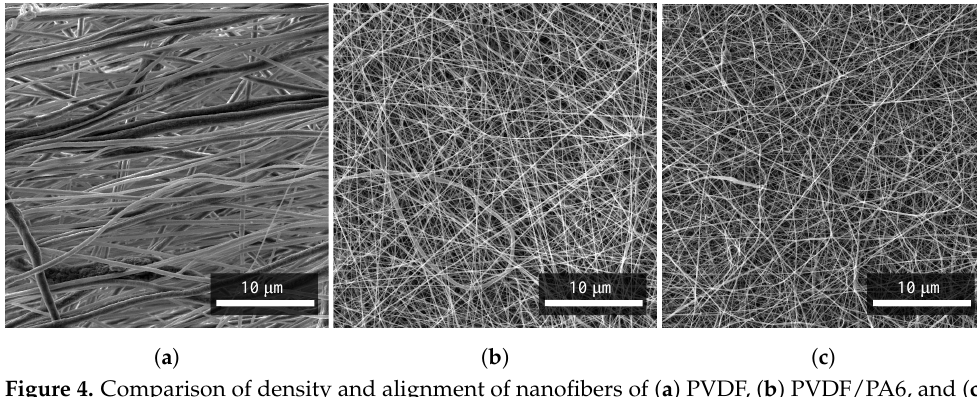
Figure 4. Comparison of density and alignment of nanofibers of ( a ) PVDF, ( b ) PVDF/PA6, and ( c ) PA6. All nanofibers were produced with the same technology at almost identical production param- eters. Nevertheless, their difference can be seen at first glance, especially for PVDF. Measurement parameters: acceleration voltage 5kV, magnification 5.5k ×